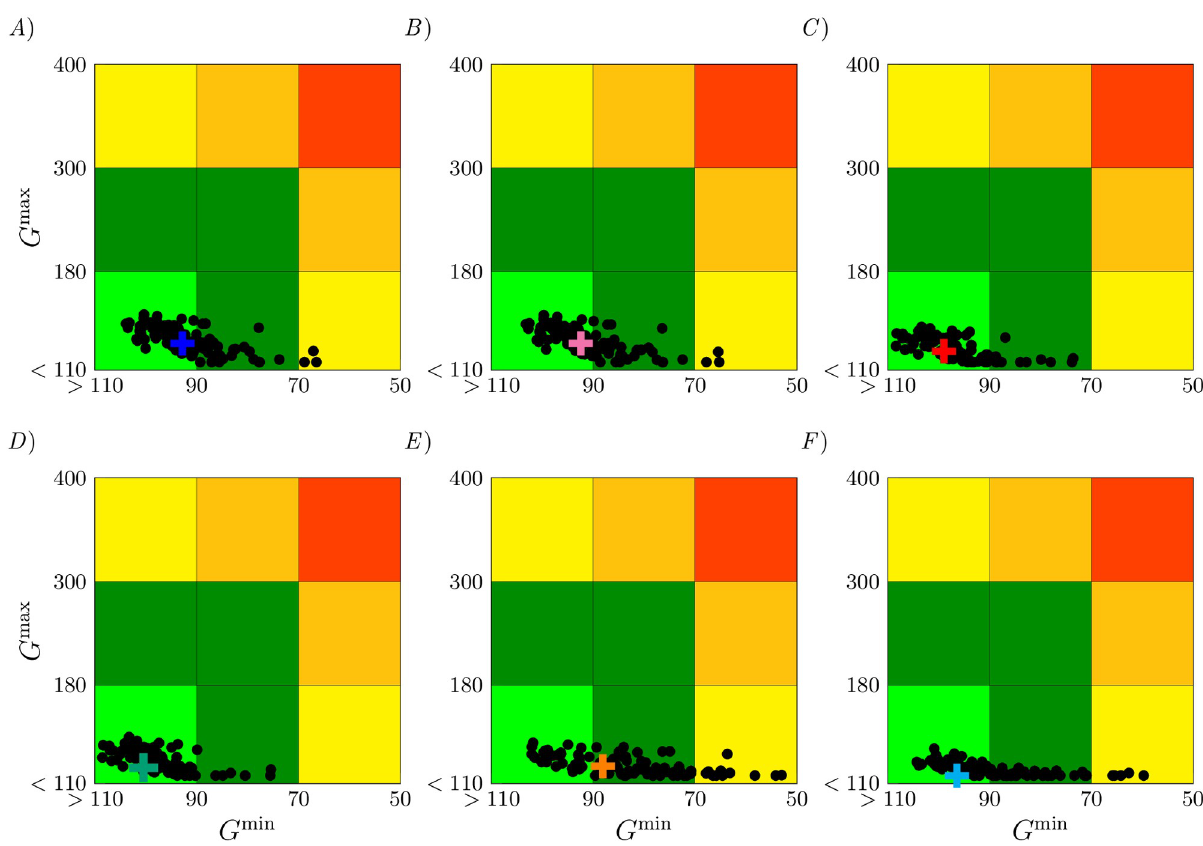
Fig 8. Robustness of the optimal control solution against parameter perturbations of the system and CVGA in the G min , G max plane. The analysis is performed for A ) ReMF ( p = 1) problem with only insulin provided, B ) ReME ( p = 2) problem with only insulin provided, C ) ReMF ( p = 1) problem with both insulin and glucagon provided, D ) ReME ( p = 2) problem with both insulin and glucagon provided, E ) the standard therapy, and F ) the proposed ad-hoc dual drug therapy. Cross symbols indicate the application of the optimal control therapies to the unperturbed